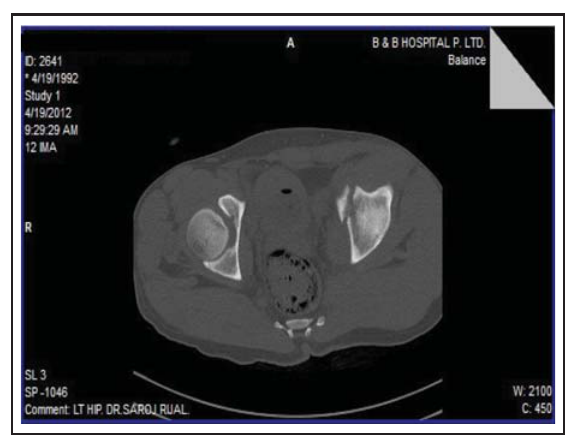
Figure 5. 20 Y/M with history of fall injury. Anterior column fracture of left acetabulum.